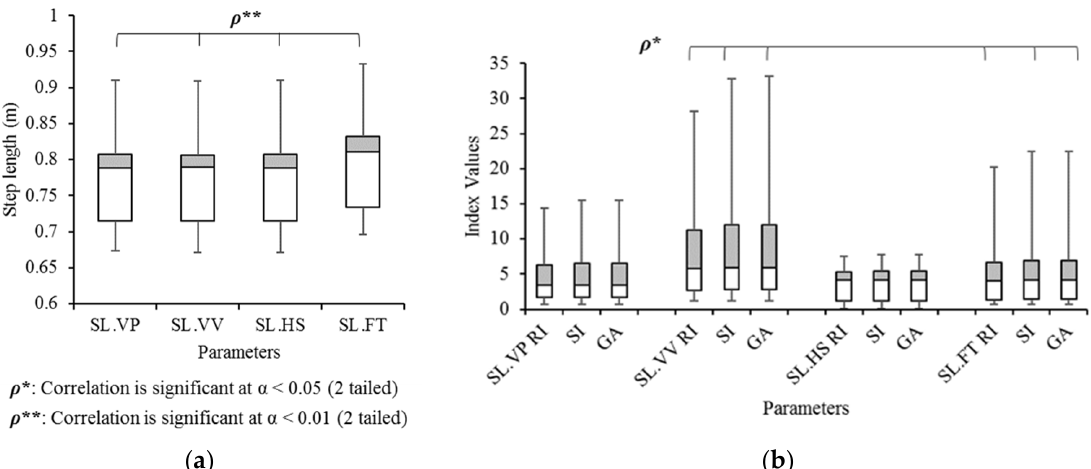
Figure 9. Box and Whisker diagrams of ( a ) the step length in four different measurement sources and ( b ) their three gait symmetry indices.